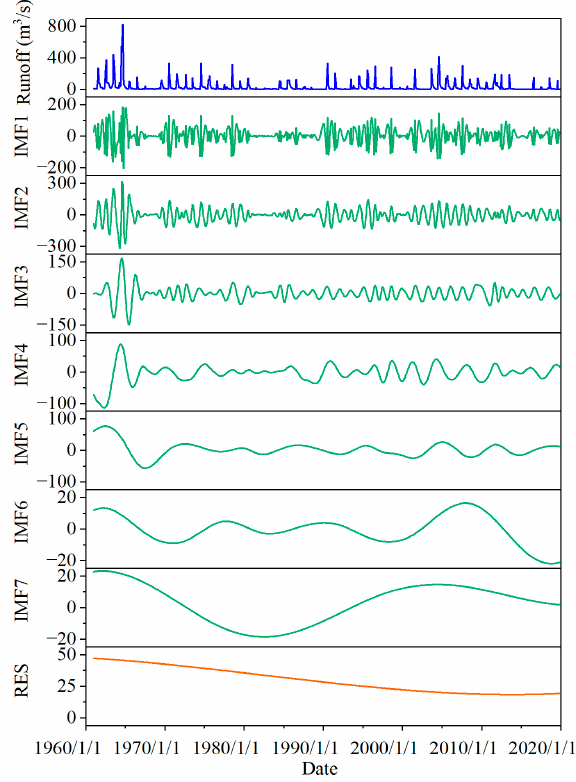
Figure 17. The decomposition results of the CEEMDAN method for runoff at Daicunba station.